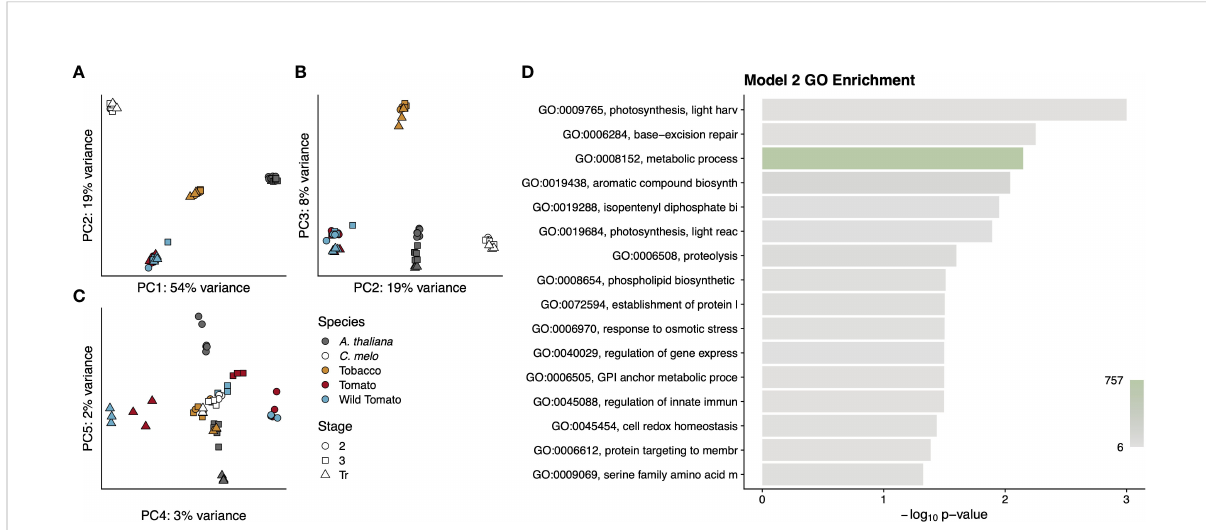
FIGURE 8 Summary of genes from Model 2. Principal components analysis (A-C) of gene expression values for each RNA-seq library. Points are colored by species and shaped by developmental stage as indicated in the legend. Principal components used for each graph are indicated on the axis along with the proportion of variance explained. A GO analysis (D) for the entire cohort of genes. GO term names to the left of the graph are truncated to available space. Terms are sorted by p-value, which is indicated by the bar height. Bars are colored by the number of genes annotated to that term, as indicated by the colour scale in the lower